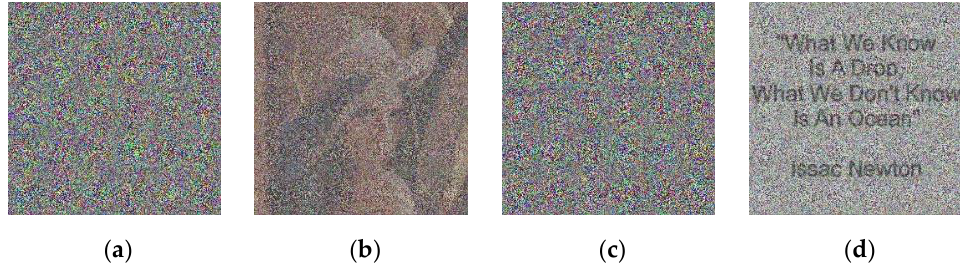
Figure 13. ( a ) Lena_encrypted.jpeg under a salt and pepper noise attack with a density of 75%, ( b ) Decryption of Lena_encrypted.jpeg after noise attack with a density of 75%, ( c ) Message_encrypted.jpeg under a salt and pepper noise attack with a density of 75%, ( d ) Decryption of Message_encrypted.jpeg after noise attack with a density of 75%.